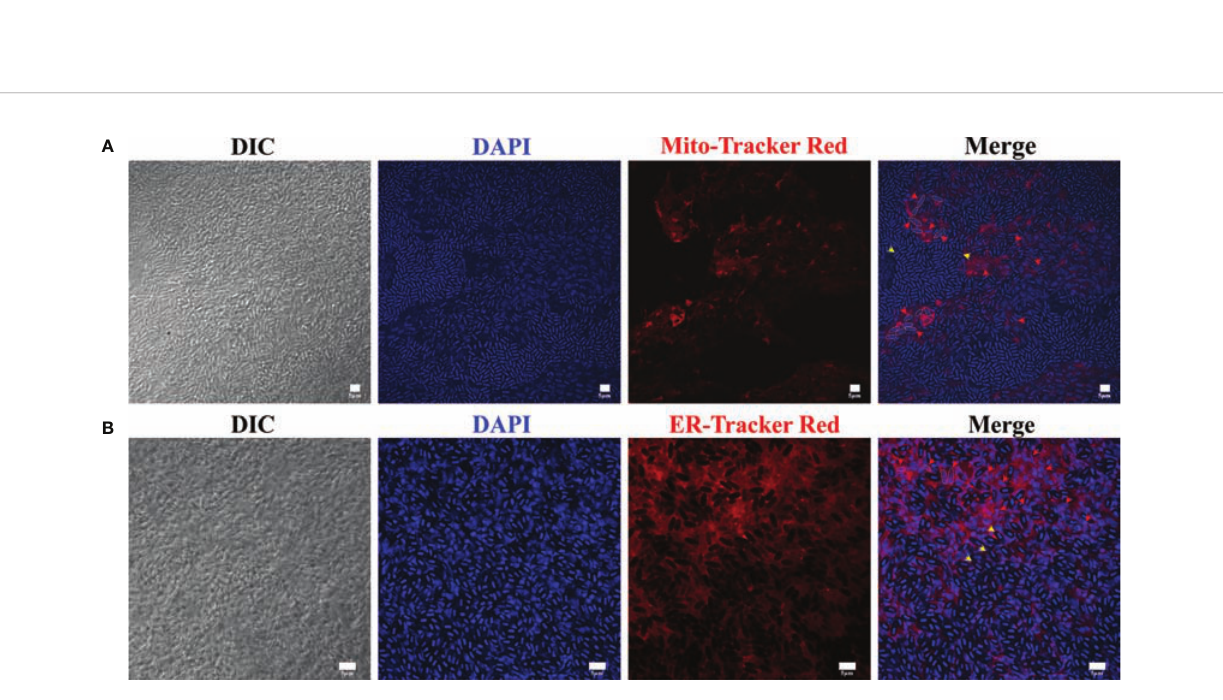
FIGURE 5 | The observation of xenoma mitochondria and endoplasmic reticulum (ER). (A) The xenoma was stained with Mito-Tracker Red for labeling mitochondria (red) and DAPI for dying nucleus (blue). (B) The xenoma was stained with ER-Tracker Red for labeling ER (red) and DAPI. The nucleus of meronts (red arrowhead) and spores (yellow arrowhead) were stained with DAPI (blue). Bar, 5